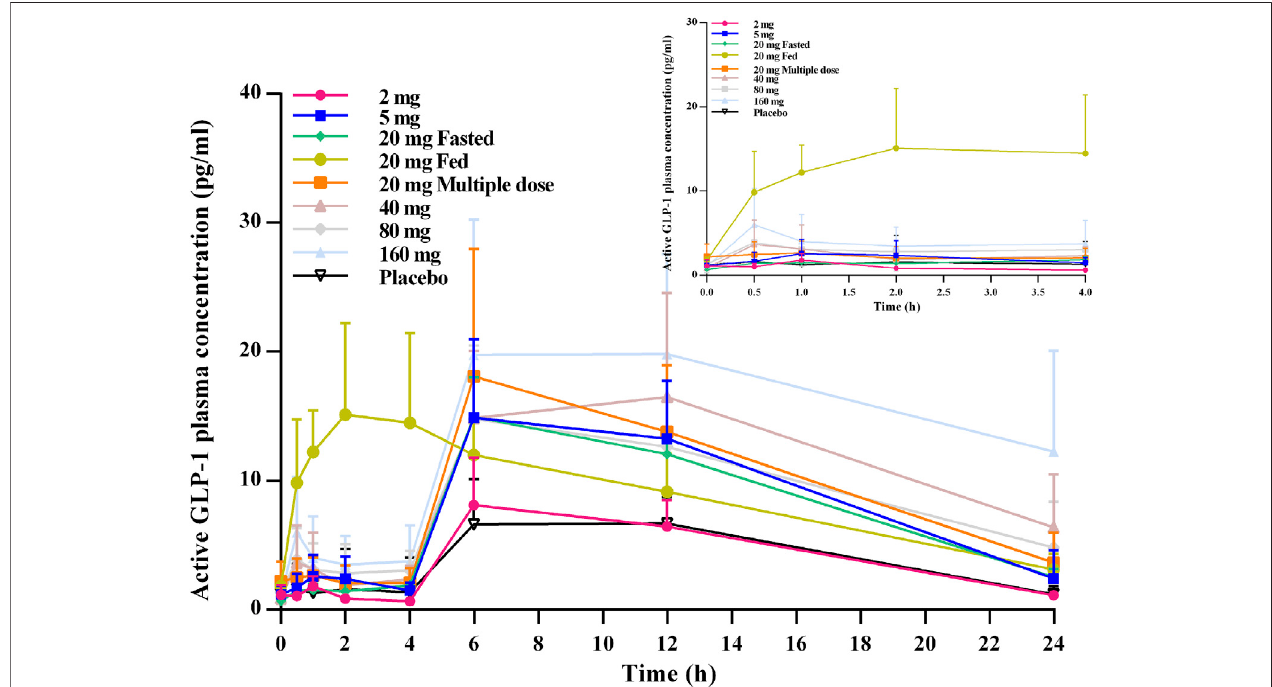
FIGURE 4 | Mean (SD) active GLP-1 – time pro fi les after oral administration of TQ-F3083 at doses of 2 – 160 mg.